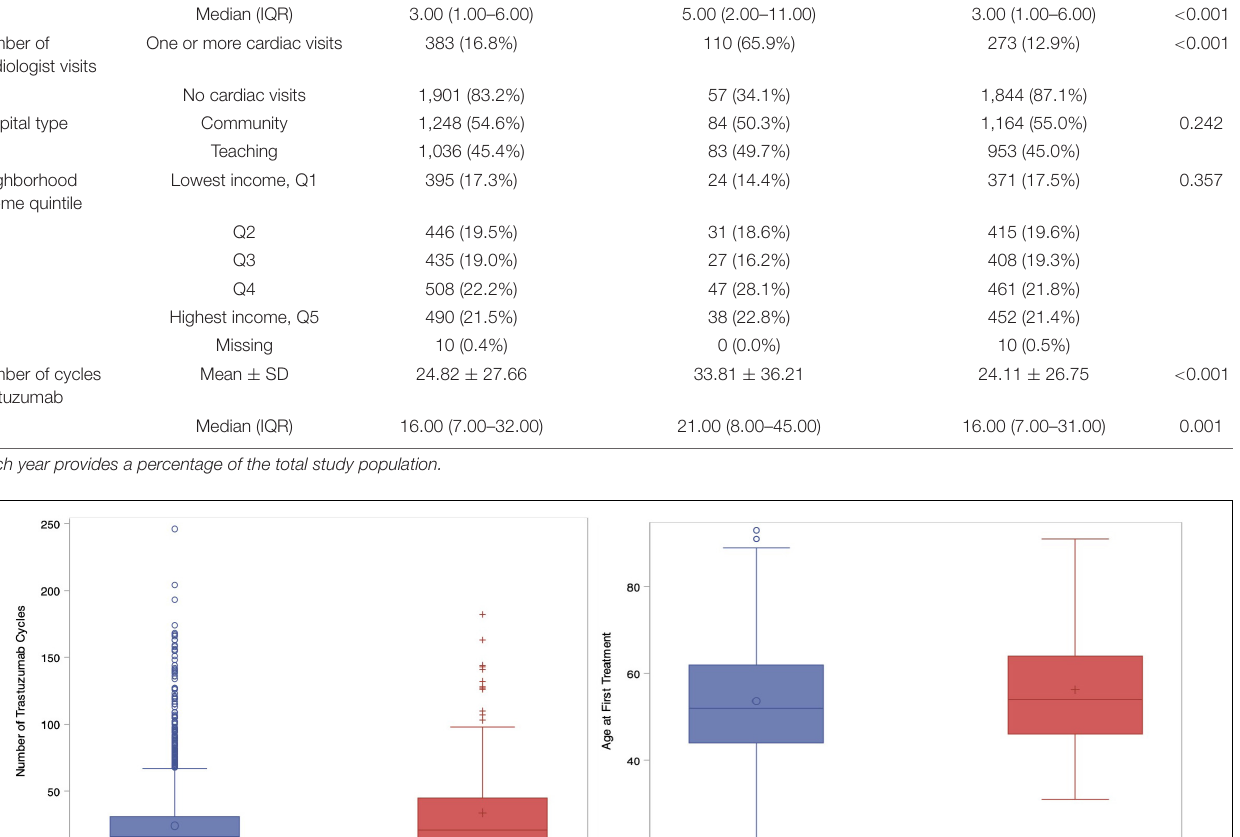
respectively (21); after 4 years of treatment, the cumulative incidence of severe cardiotoxicity (LVEF < 40%) was